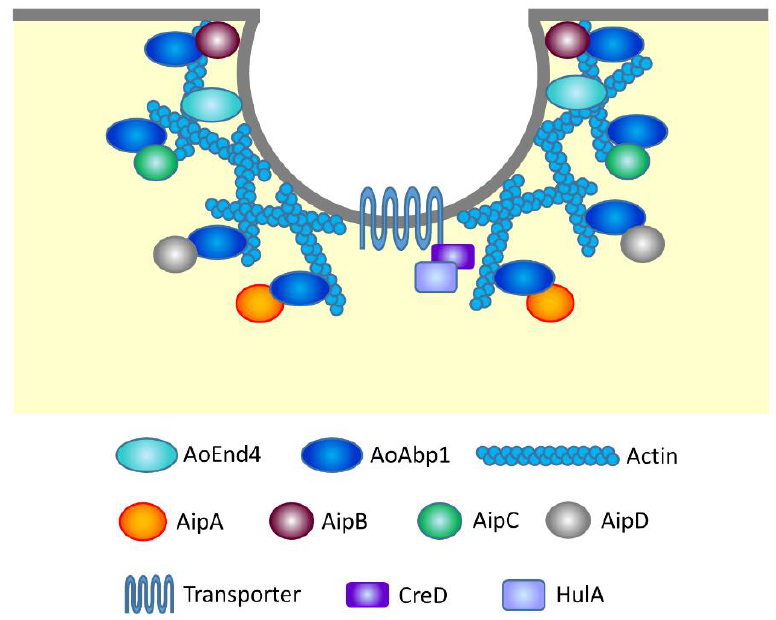
Figure 3. Schematic diagram of endocytic proteins involved in transporter endocytosis in A. oryzae